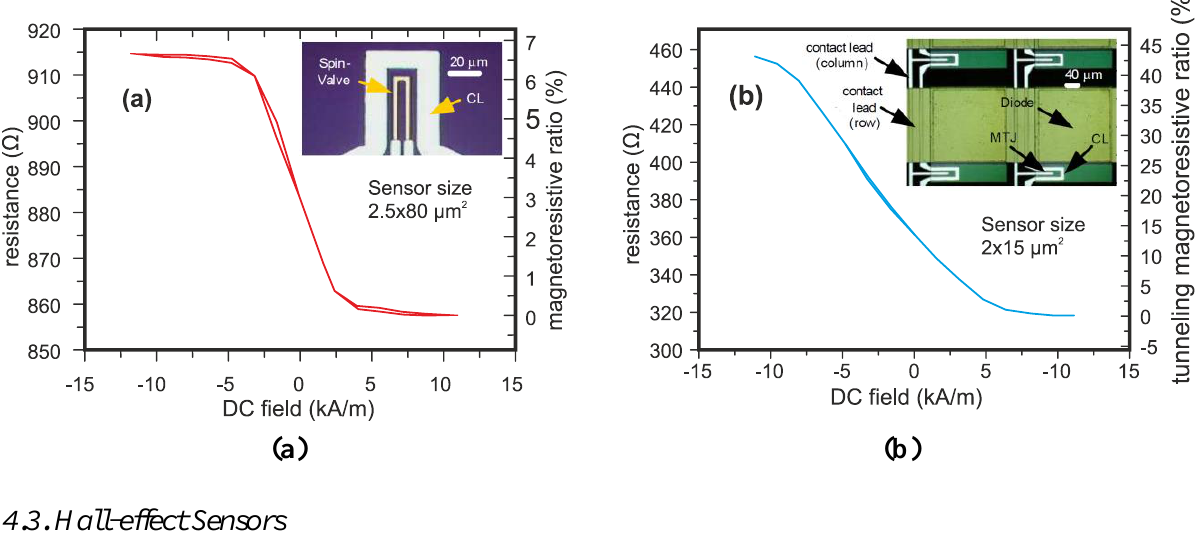
Figure 27. Microphotography and transfer curve of two types of magnetoresistive sensors: (a) Spin-valve in a linear array (adapted from [67]). (b) Magnetic tunnel junction in a matrix (adapted from [67]).